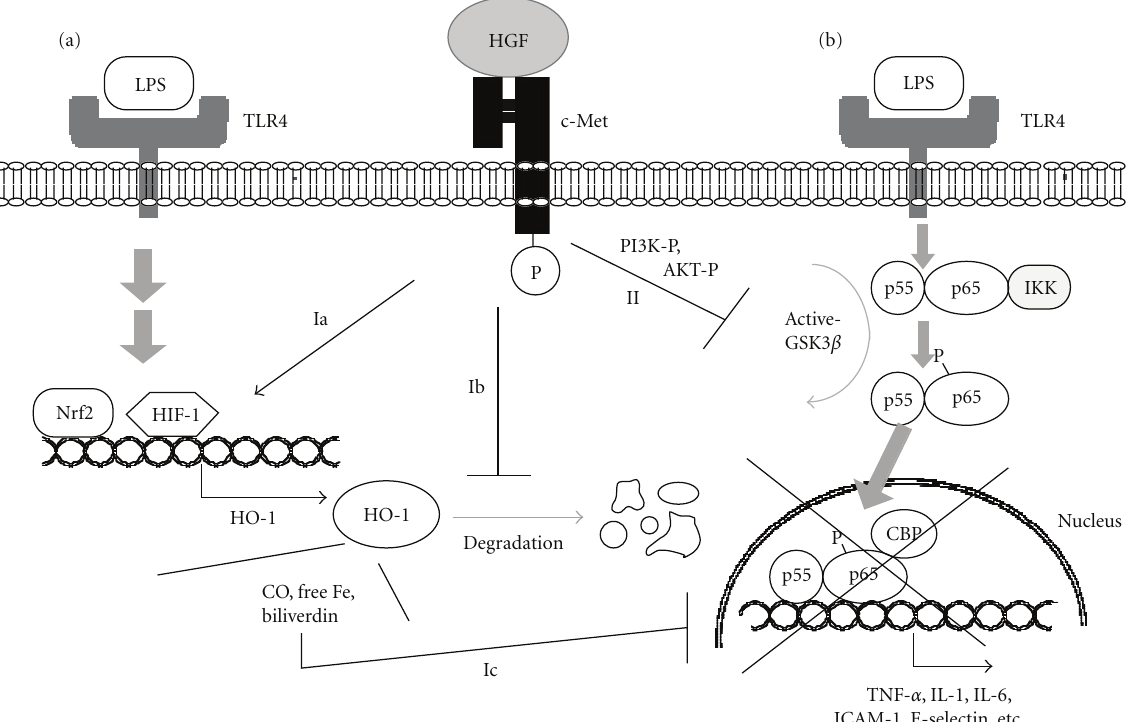
Figure 3: Molecular mechanisms of HGF-c-Met-mediated signaling for inhibiting TLR4-mediated NF- κ B activation in macrophages. (a) HO-1-dependent pathway. HO-1 is upregulated at a downstream of TLR4 through the activation of transcriptional factors, such as Nrf2 or HIF-1. During heme metabolism by HO-1, carbon monoxide (CO), free iron and biliverdin are generated, and these products attenuate NF- κ B activation (i.e., negative feedback system). In this process, c-Met signal enhances the HO-1 transcriptional pathway (1a) or stabilizes HO-1 from degradation (1b). Overall, HGF-mediated increases in HO-1 partially contribute to NF- κ B inactivation (1c). (b) GSK3 β -inactivated pathway. LPS-TLR4-mediated signaling leads to nuclear localization and activation of NF- κ B via GSK3 β activation pathway. In contrast, HGF-c-Met signaling elicits PI3K and AKT phosphorylation, and then GSK3 β is inactivated. As a result, CBP, a coactivator of NF- κ B, is sequestered from the p65 subunit of NF- κ B, and transcription of inflammatory molecules, such as TNF- α , IL-6 and ICAM-1, is